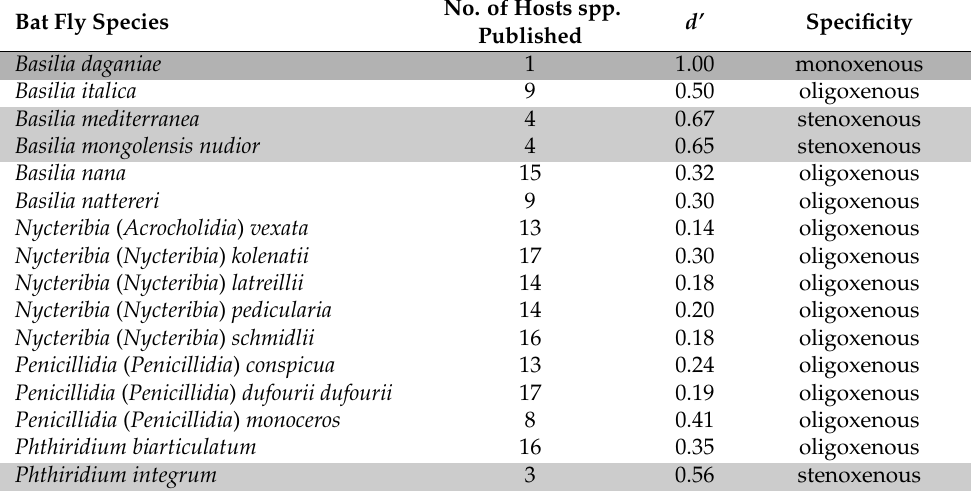
Table 1. The number of hosts published and the index of bat flies’ specialization at the species level (d’), and the specificity of European bat fly species. Grey rows mean high specialization and dark grey rows mean the highly specialized monoxenous species. No. of Hosts spp. d’ Bat Fly Species Published